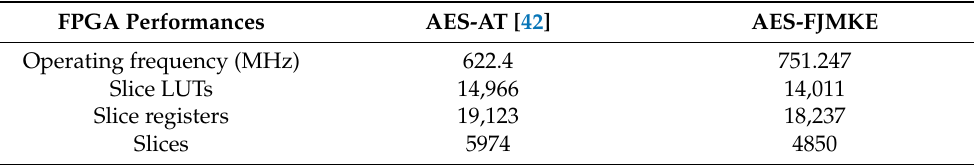
Table 10. Comparison of AES-FJMKE and AES-BE for Virtex 6.